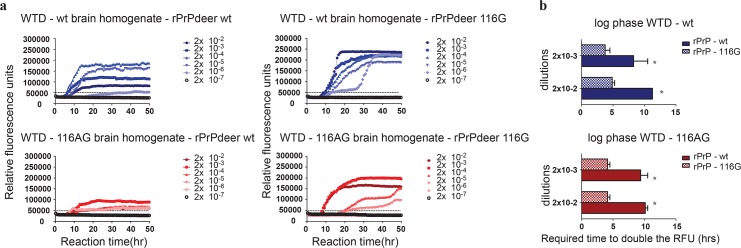
Efficiency of amyloid fibril formation using rPrP-116G substrate in RT-QuIC.(a) The curves depict a representative RT-QuIC response of serially diluted (2x10-2 to 2x10-7) wt (upper panels) and 116AG (lower panels) WTD brain homogenates using rPrP-wt (right panels) or rPrP-116G (left panels) as substrates. Fluorescence signals were measured every 15 min. The x-axis represents the reaction time (hours), the y-axis represents the relative fluorescence units. Mean values of four replicates were used for each dilution. The cut-off is indicated at app. 50,000 RFU and is based on the average fluorescence values of negative controls +5SD. (b) The RT-QuIC responses of wt- and 116AG-prions were quantified by calculating the log phase for each isolate amplified using rPrP-wt or rPrP-116G. Mean values of 3 experiments with 4 replicates each were used for each isolate and statistical analyses were done using unpaired t-test for the log phase (b).